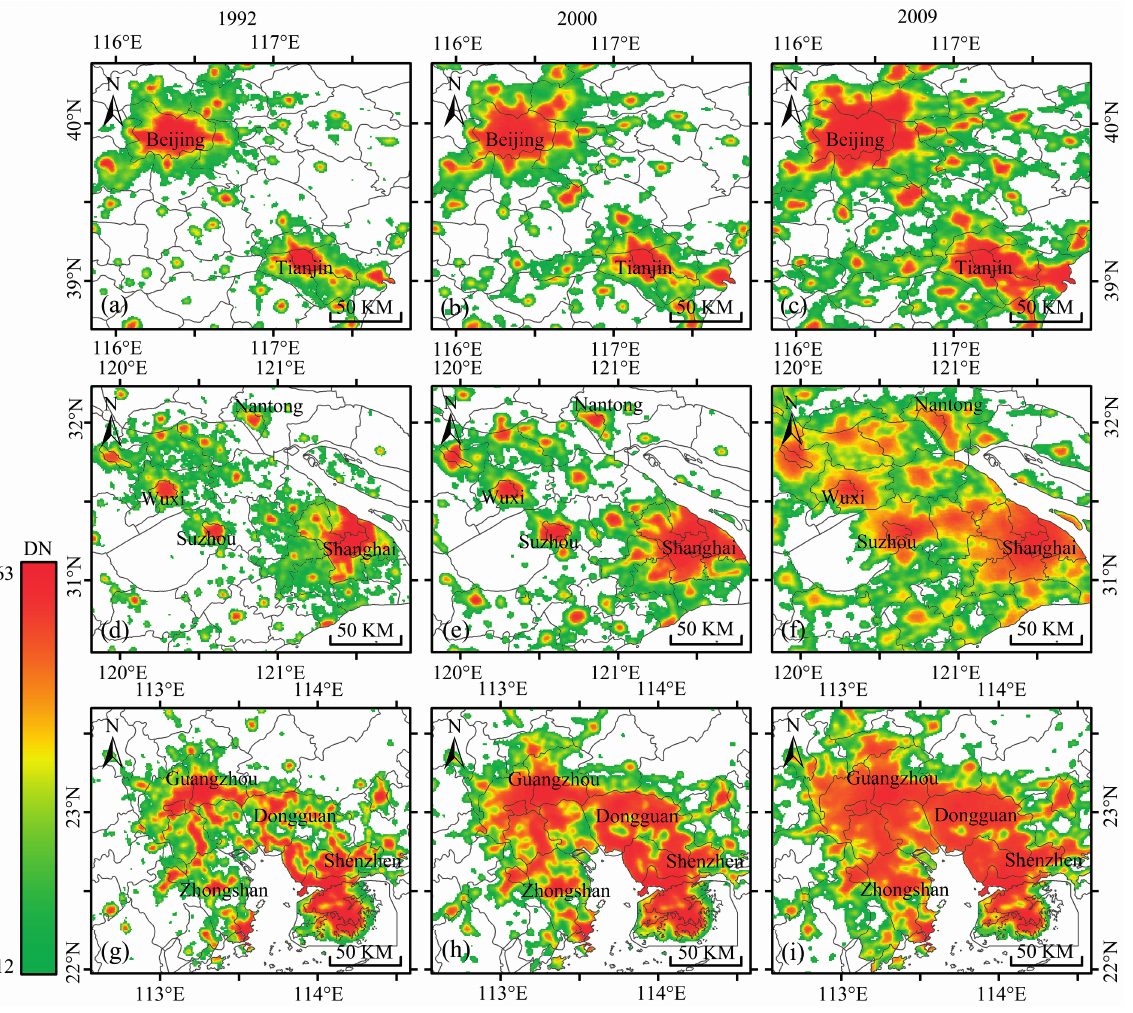
Figure 1. Temporal-spatial changes in DMSP/OLS lit areas of Chinese cities located in Beijing-Tianjin region ( top row , ( a – c )), Yangtze River Delta ( second row , ( d – f )) and Pearl River Delta ( third row , ( g – i ))) in 1992 (left column), 2000 (center column), and 2009 (right column). The DN value of Night light brightness range from 12 to 63 is interpolated from green to red. Administrative boundaries are drawn by solid gray